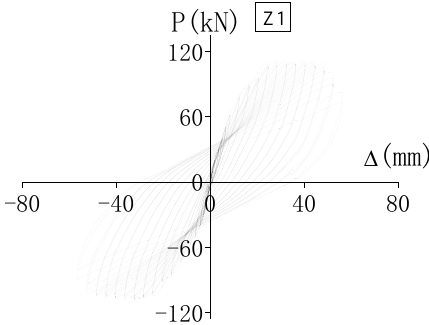
Figure 11. Hysteretic curve Z1 ( ρ = 0).